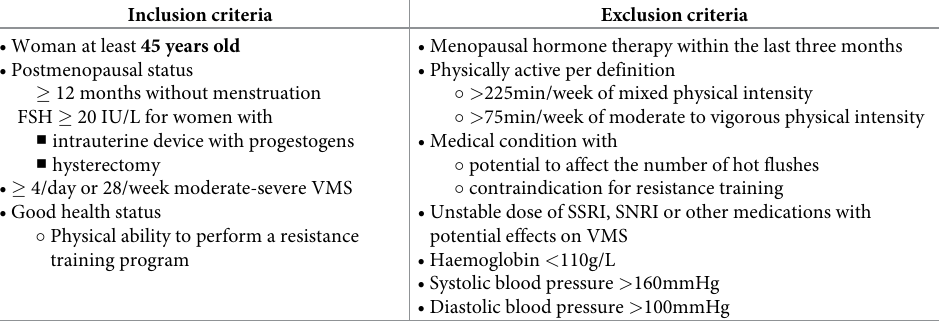
Table 1. Inclusion and exclusion criteria for the women included in the